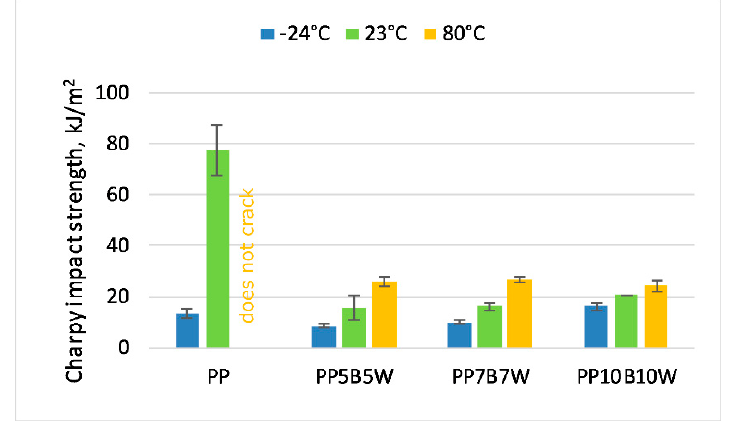
Figure 5. Unnotched Charpy impact strength of tested materials at − 24 °C, 23 °C, and 80